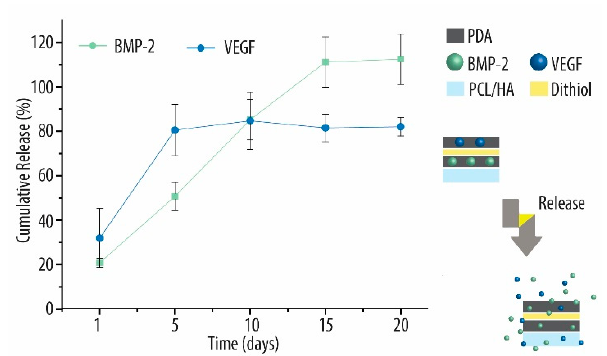
Figure 2. Release profiles of BMP-2 and VEGF from the sca ff olds: PCL / HA-composite sca ff olds have been coated with polydopamine (PDA) entrapping BMP-2 and VEGF growth factors within two di ff erent layers (PDA@B / PDA@V). A dithiol linker has been incorporated to allow for the deposition of a second PDA